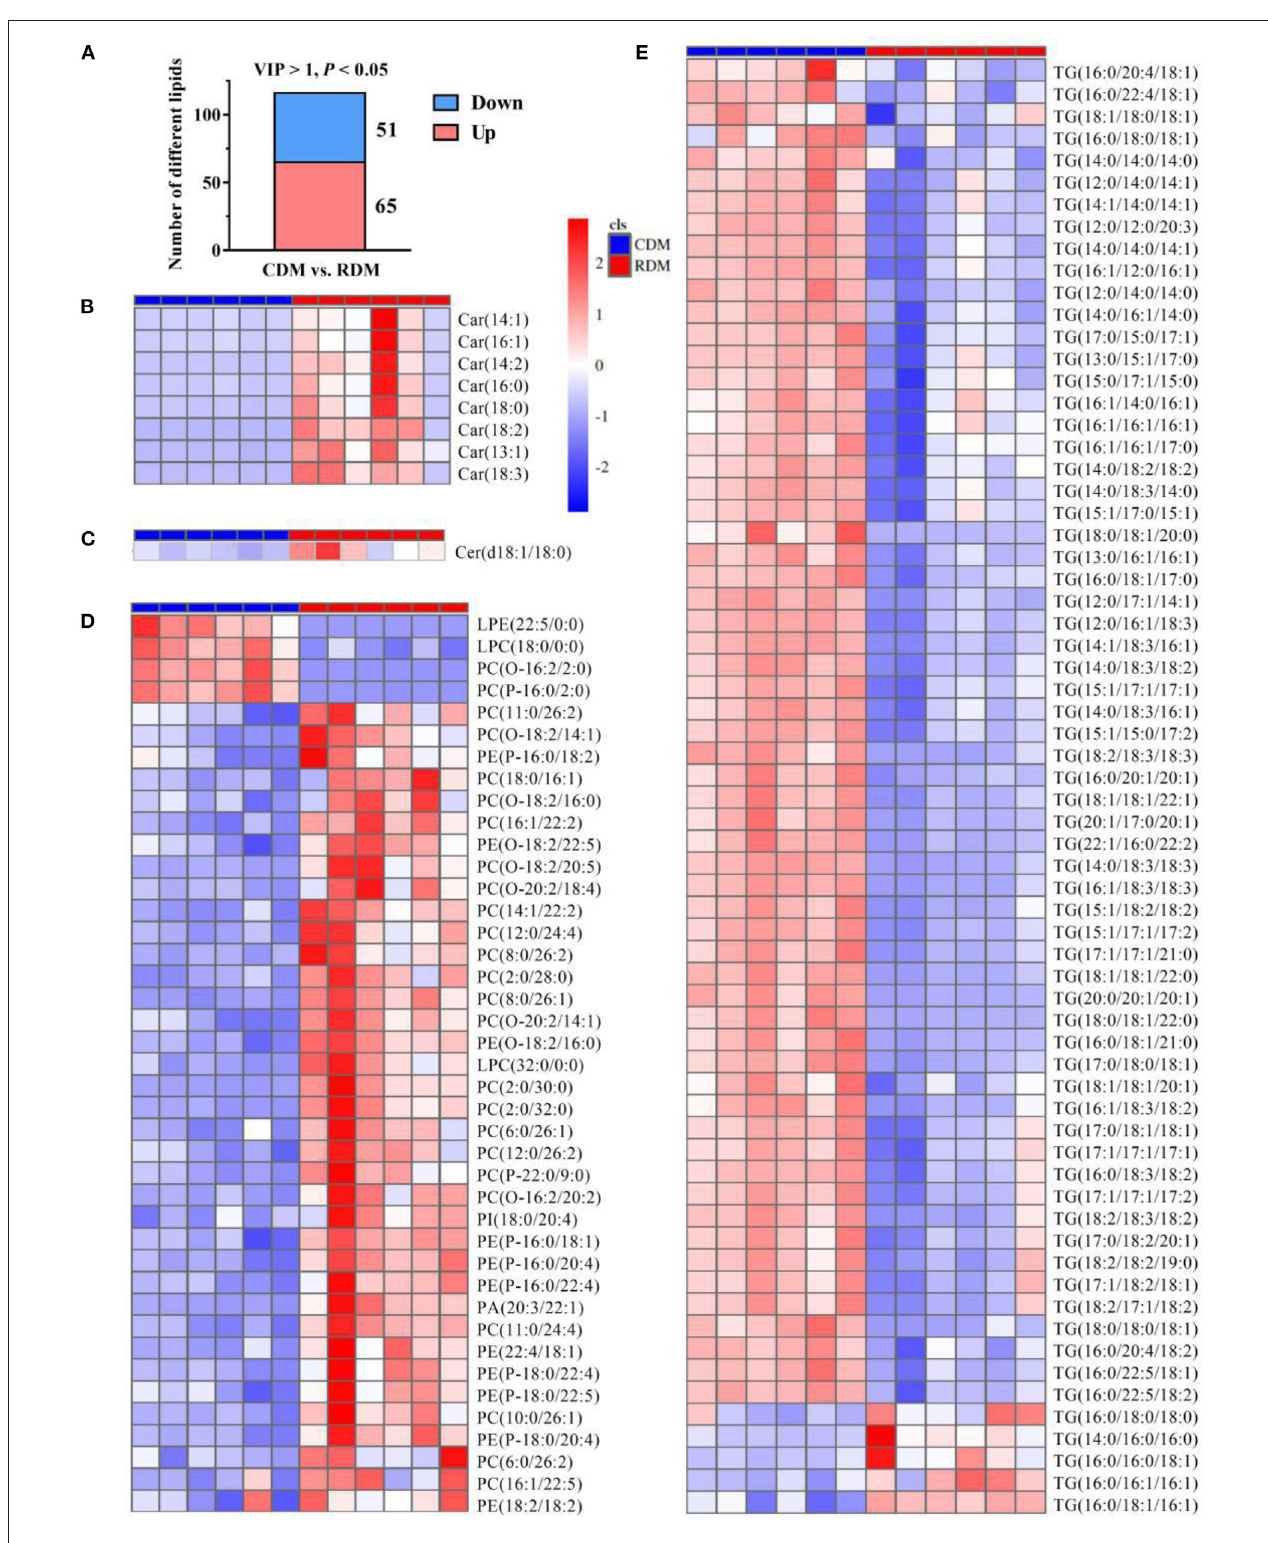
FIGURE 5 | Differential lipids in cooked and raw donkey muscles. (A) The number of significantly differential lipids in CDM vs. RDM. (B–E) Heatmap analysis of carnitines [Cars; (B) ], ceramides [Cers; (C) ], glycerophospholipids [GPs; (D) ], and triglycerides [TGs; (E) ].